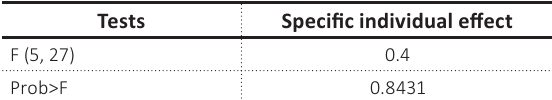
Table 7. Test of individual effects